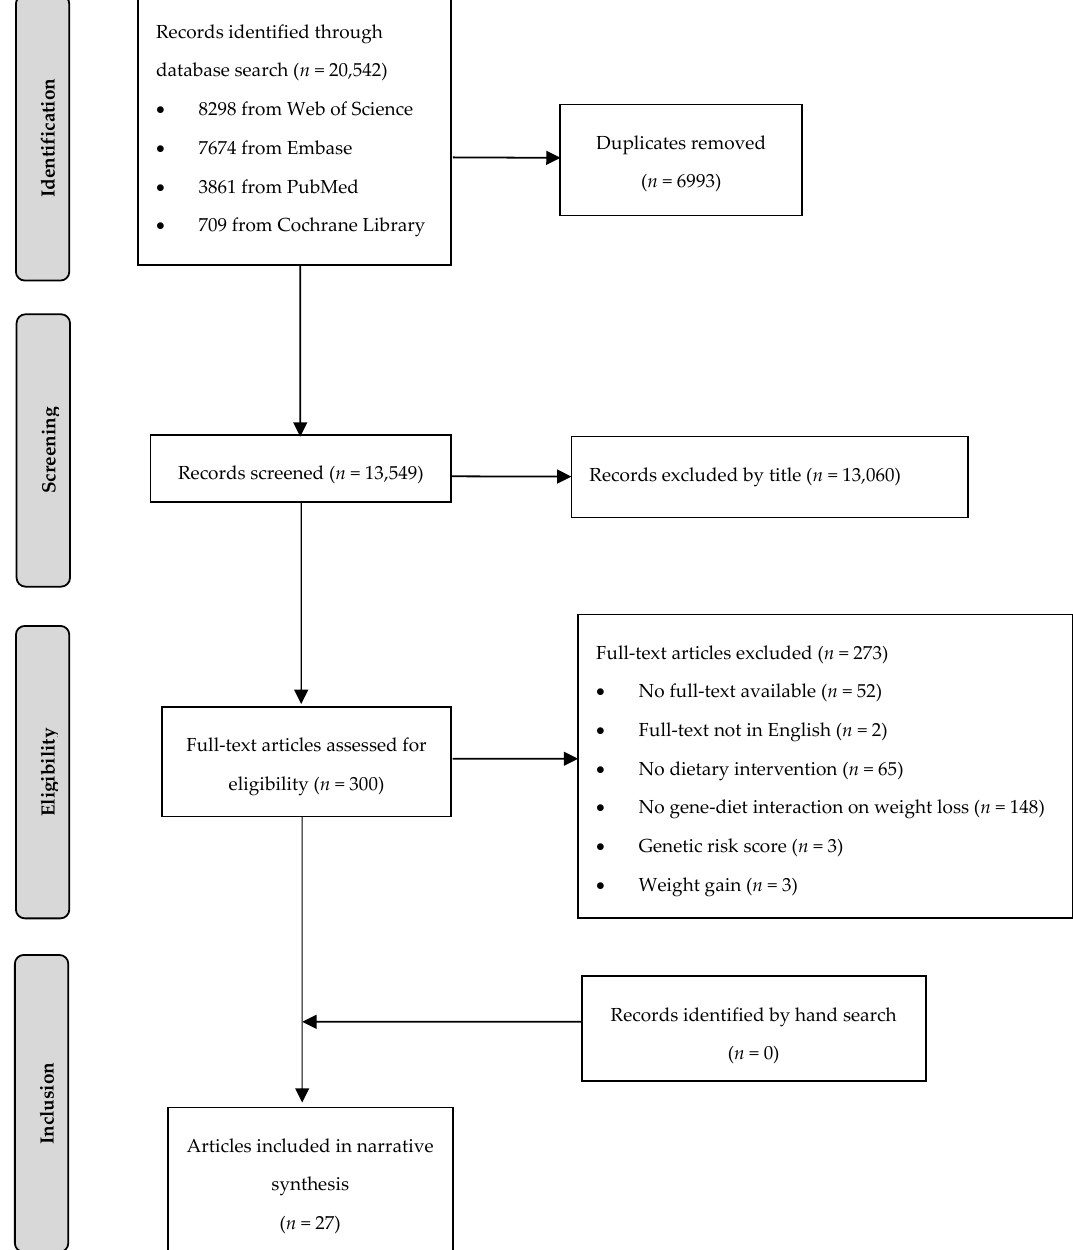
Figure 1. Flow chart of the systematic literature search according to Moher et al. [24].